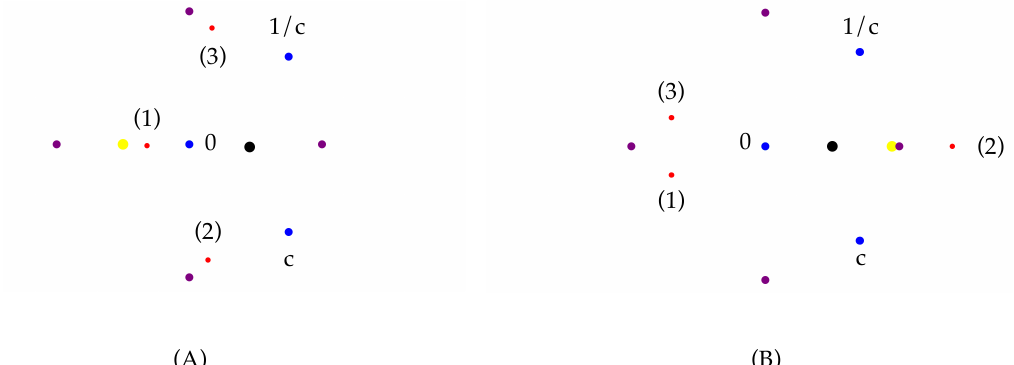
Figure 19: Manipulate environment in Mathematica . The purple dots are added by hand, fixed and give a frame of reference. The yellow dot sets the value of α and moves in a parameter plane. The blue dots give the location of the branch points in dependence of α and live on the t -plane. The black dot determines a value for t in the t -plane. The red dots are the three sheets w ( t ) for given t and move in the cotangent plane of the Gaiotto curve. The yellow and black dot can be dragged using the cursor. The black dot is to be dragged along the paths γ . The subfigure i labelled (A) and (B) give the w -curve with ( ∓ ) in (218) respectively. The numbers in brackets are attached to the red dots and give a labelling of the three sheets in a neighbourhood of t = 1 / 2. The labels c ,1 / c mark the location of the branch points. The singularities are at t = 0, ∞ of which the first is